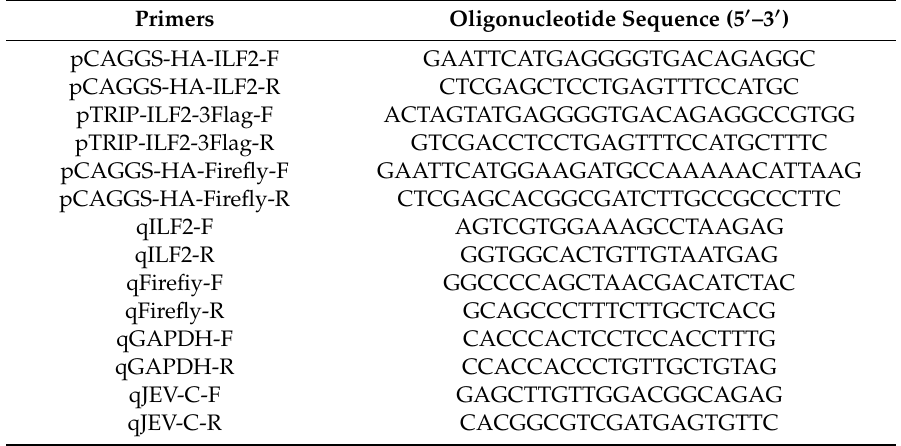
Table 1. List of primers used in this